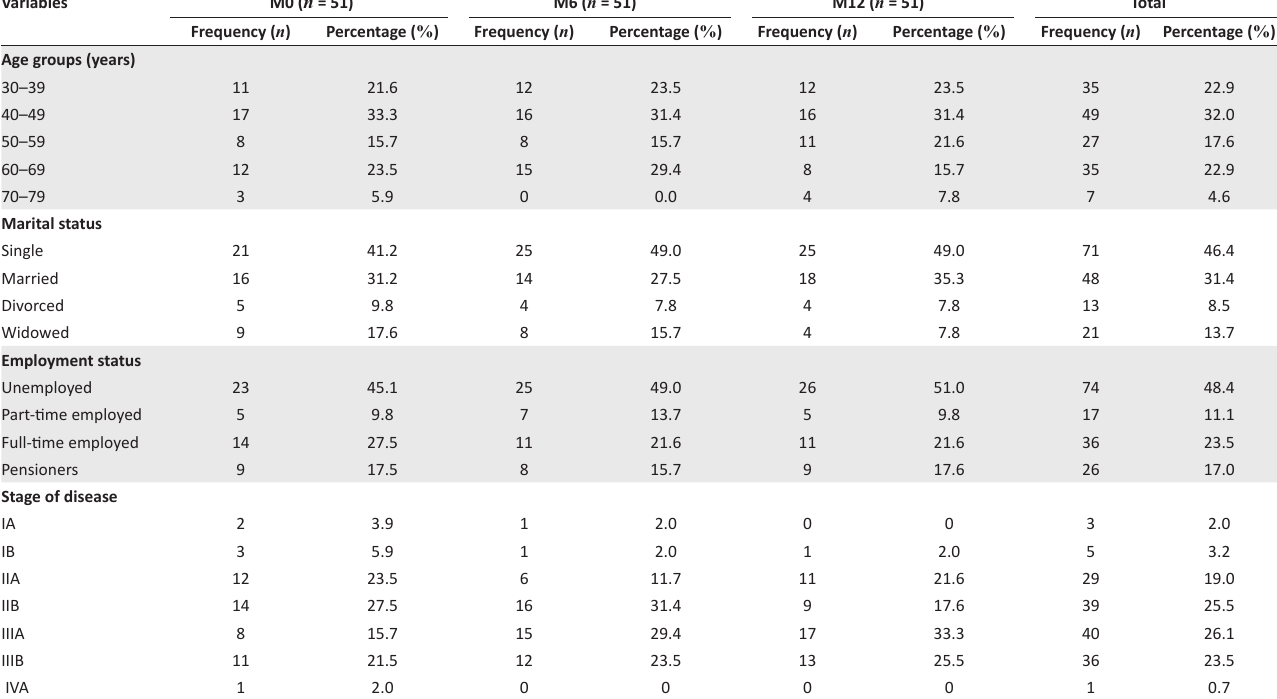
TABLE 1: Demographic characteristics of the respondents ( n = 153). Variables Age groups